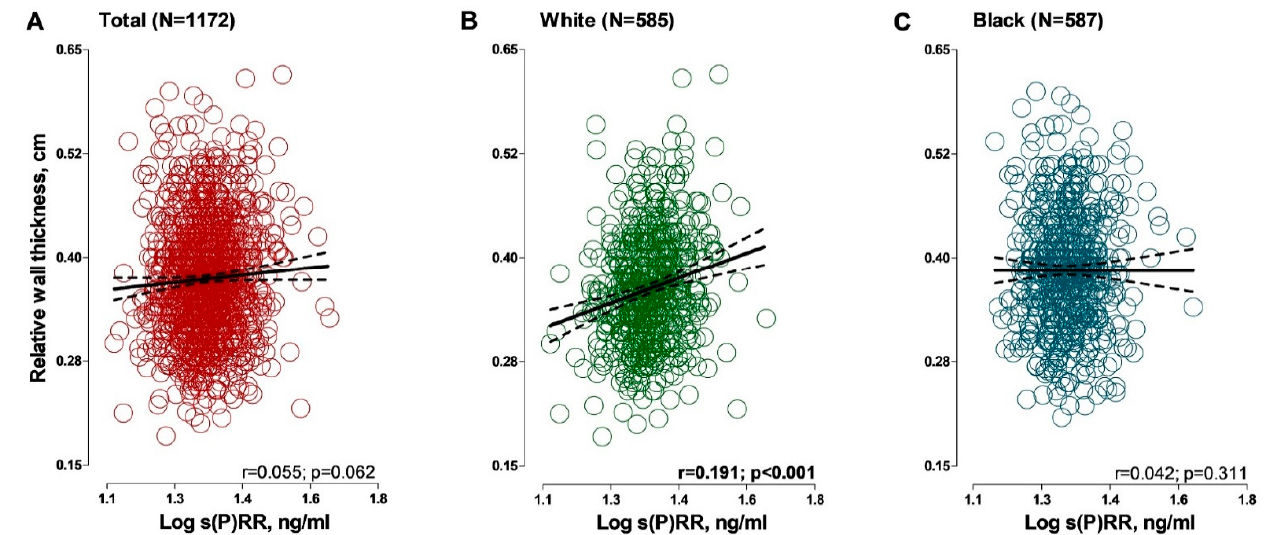
Figure 2. Associations between relative wall thickness and soluble (pro)renin receptor in ( A ) total group; ( B ) black group and ( C ) white group. Solid and dashed lines represent the regression line and 95% CI boundaries, respectively. Abbreviations: s(P)RR, soluble (pro)renin receptor. Table 3. Partial correlations between left ventricular indices and soluble (pro)renin receptor. Soluble (Pro)renin Receptor (ng/mL)